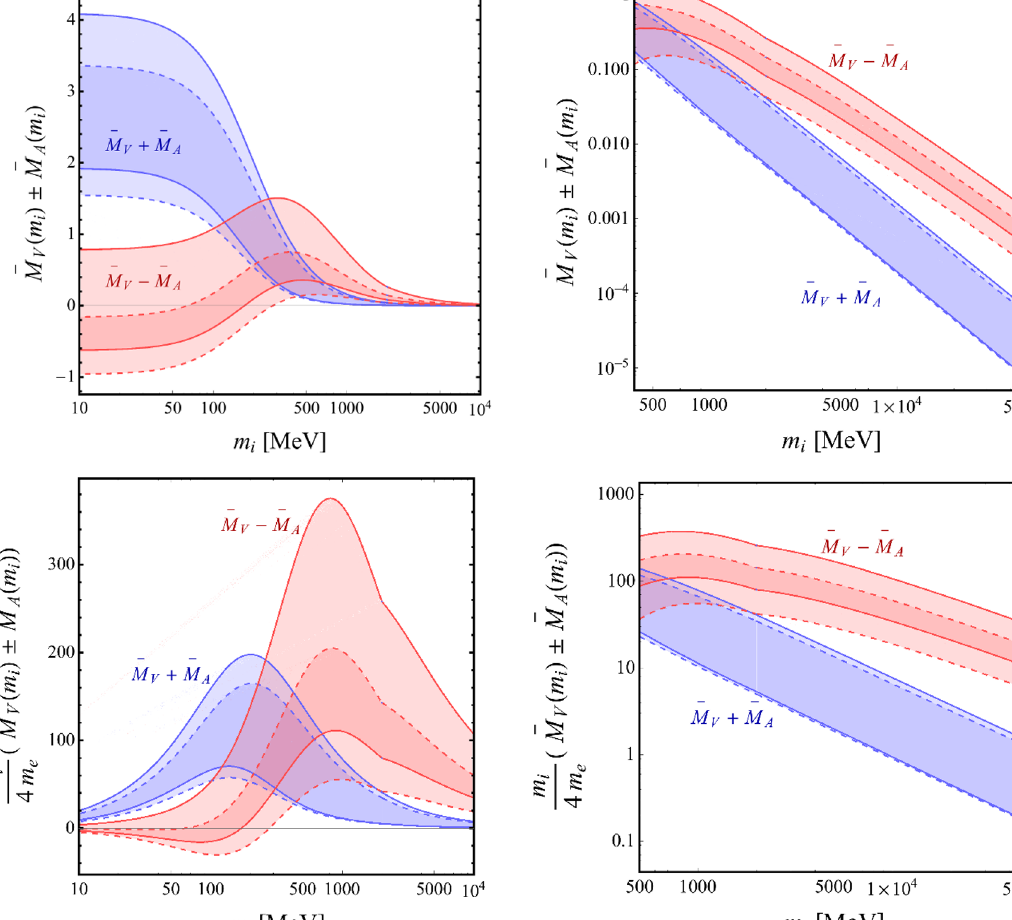
Figure 5 . Top-left panel: the dependence of (cid:22) M V + (cid:22) M A (blue) and (cid:22) M V (cid:0) (cid:22) M A (red) as a function of m i for 136 Xe NMEs obtained with QRPA (solid) or the Shell Model (dashed). The bands re(cid:13)ect the uncertainty due to LECs associated with hard-neutrino exchange. Top-right panel: same as top-left panel but for larger neutrino masses. The relative enhancement of (cid:22) M V (cid:0) (cid:22) M A at large neutrino masses is due to the behavior of the LEC g (cid:25)(cid:25) ( m i ). Bottom-left panel: the dependence of LR ( m i = 4 m e )( (cid:22) M V (cid:6) (cid:22) M A ) (blue) as a function of m i for 136 Xe NMEs. Bottom-right panel: same as bottom-left panel but larger m i